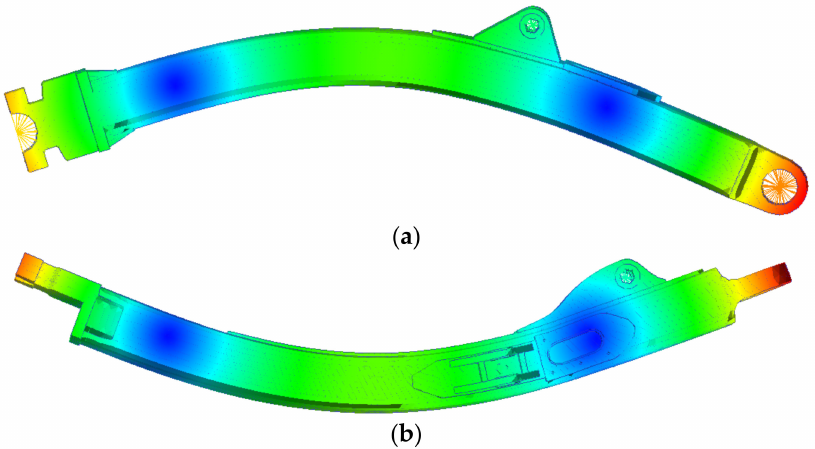
Figure 2. Mode shapes of the right push arm: ( a ) the first mode shape; ( b ) the second mode shape.